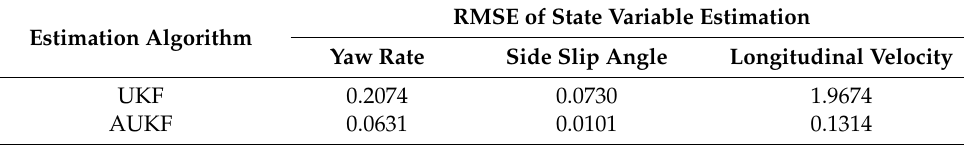
Table 3. RMSE of the two algorithms during the entire duration of the process. Estimation